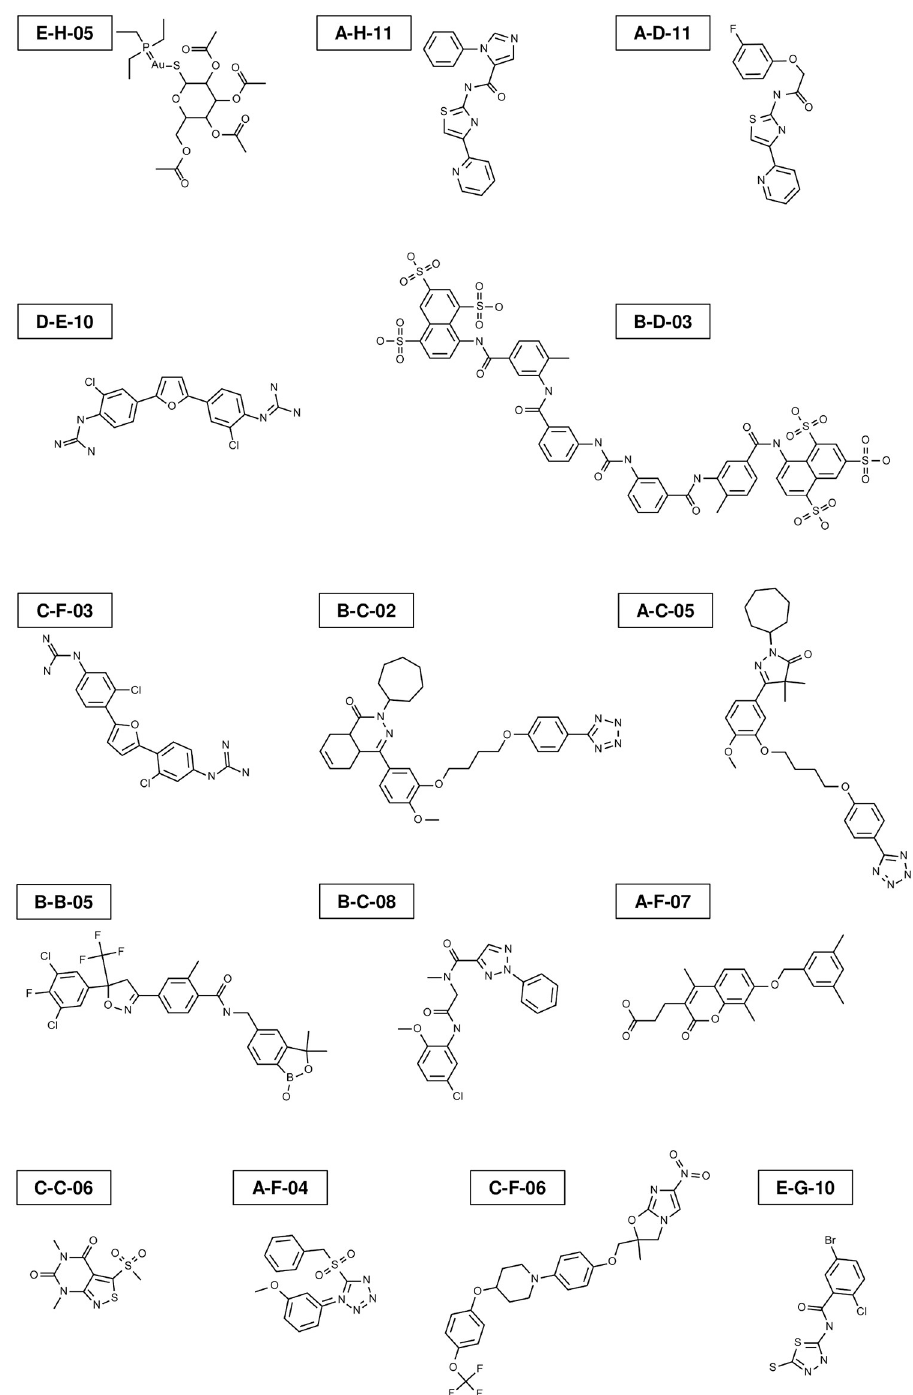
Fig 3. Chemical structures of 15 compounds that reproducibly inhibited rEhAPSK activity.